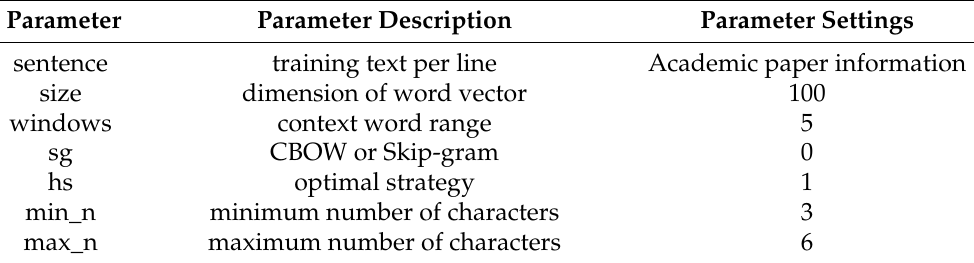
Table 1. Parameter setting of fastText training semantic word vector